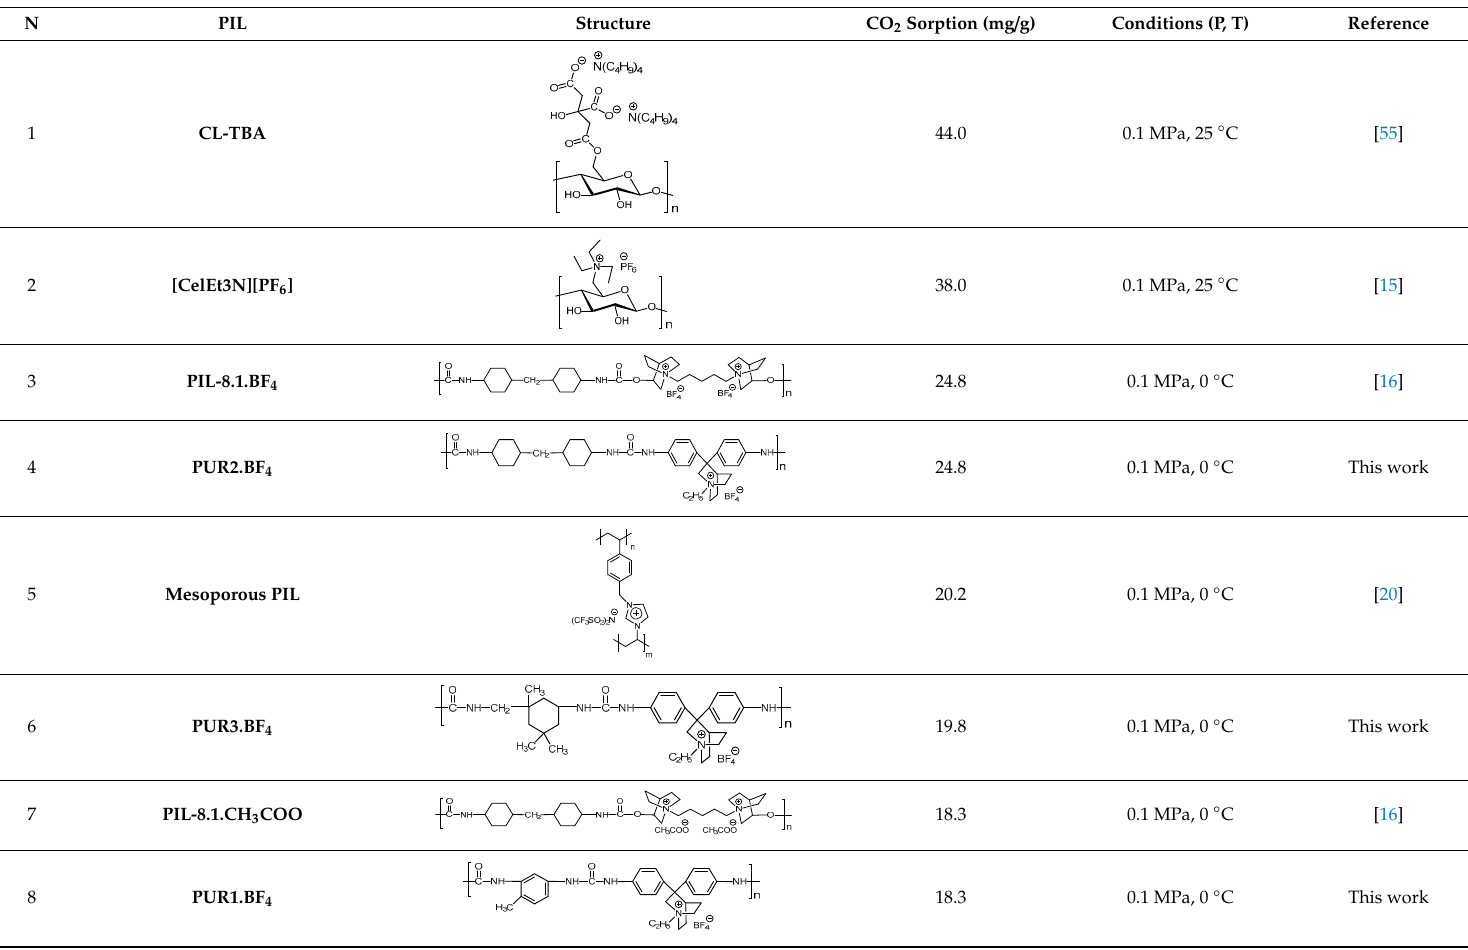
Table 2. Comparison of the CO 2 absorption data for the best PILs reported in the literature and for those obtained in the present work. Structure N PIL Structure